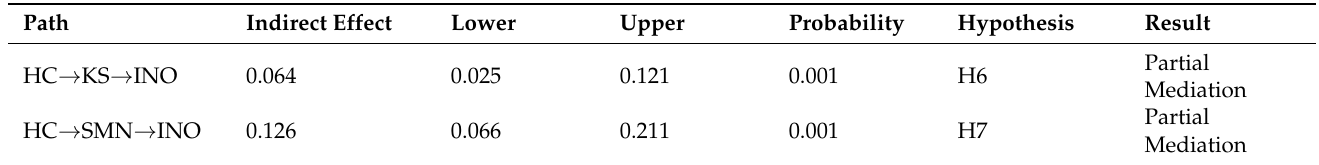
Table 5. The specific and indirect